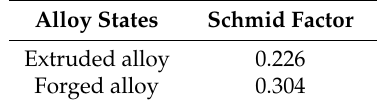
Figure 6. ( a ) Different grain orientations and inverse pole figures in the forged and extruded alloy; ( c ) analysis of grain orientation and inverse pole figures in the forged alloy; and ( b ) and ( d ) analysis of grain orientation and inverse pole figures in the extruded alloy. RD and ND mean the rolling direction and the normal direction of the sample, respectively, and TD means the transverse direction. The analyzed planes were taken from the plane of RD and TD, which was perpendicular to ND. Table 2. Average Schmid factors for (0001)<2110> basal slip in the extruded alloy.